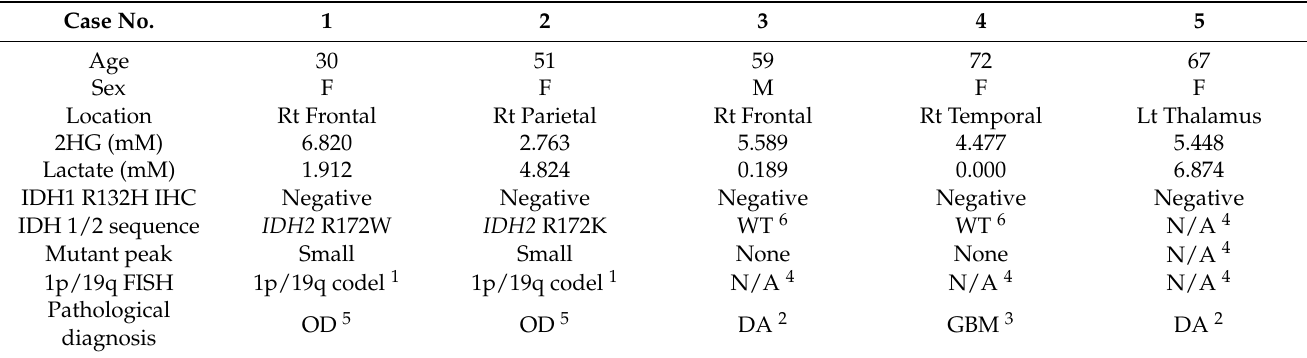
Table 1. Characteristics of the 5 presumed, false-positive cases.